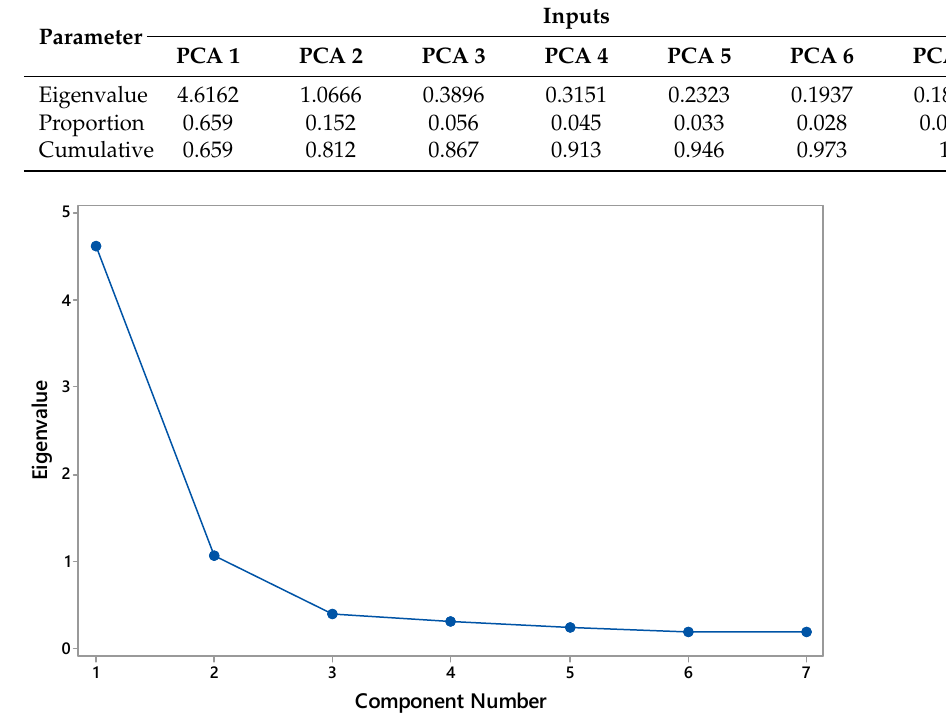
Figure 5. Eigen Analysis correlation matrix in displaying the PCA parameters.